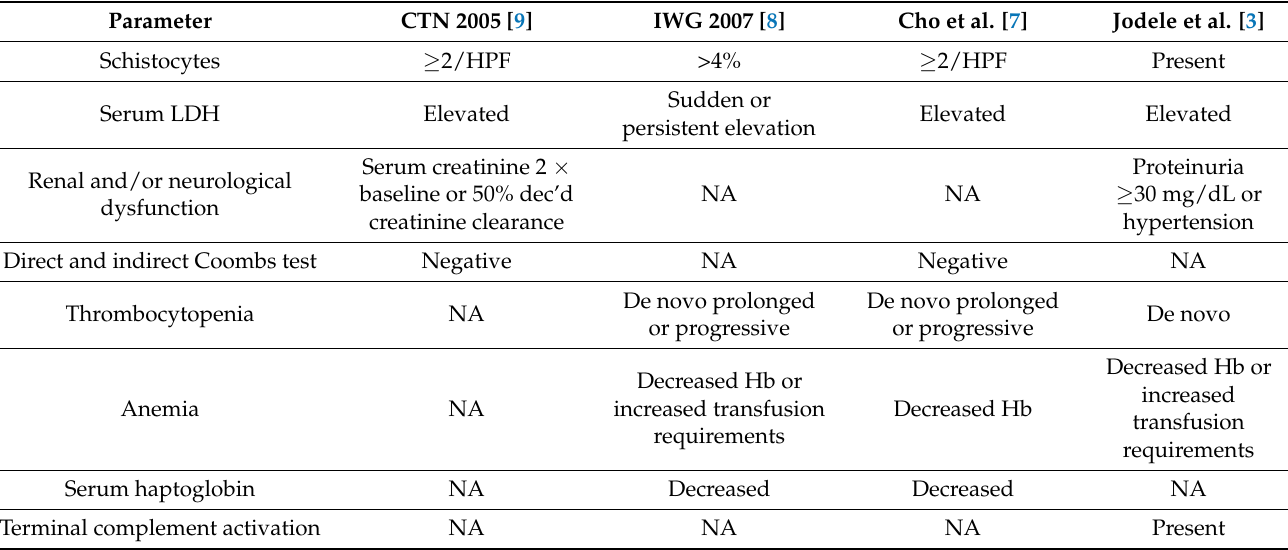
Table 1. Four diagnostic criteria for TA-TMA [10].